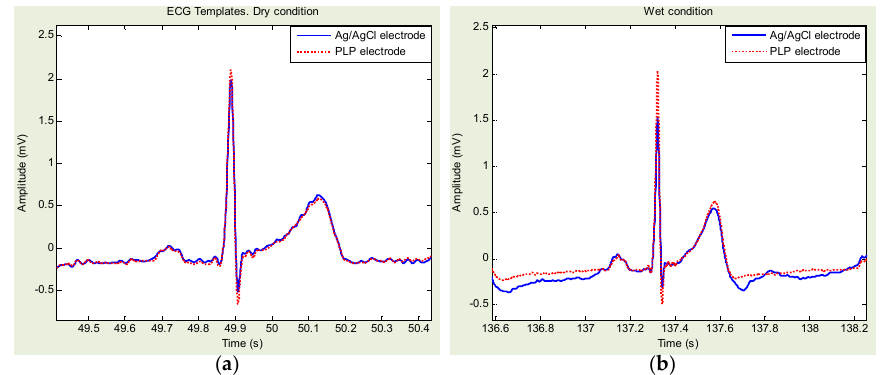
Figure 9. Example of electrocardiogram templates for dry and freshwater wet condition: ( a ) template derived from Figure 7a; and ( b ) template derived from Figure 7d.